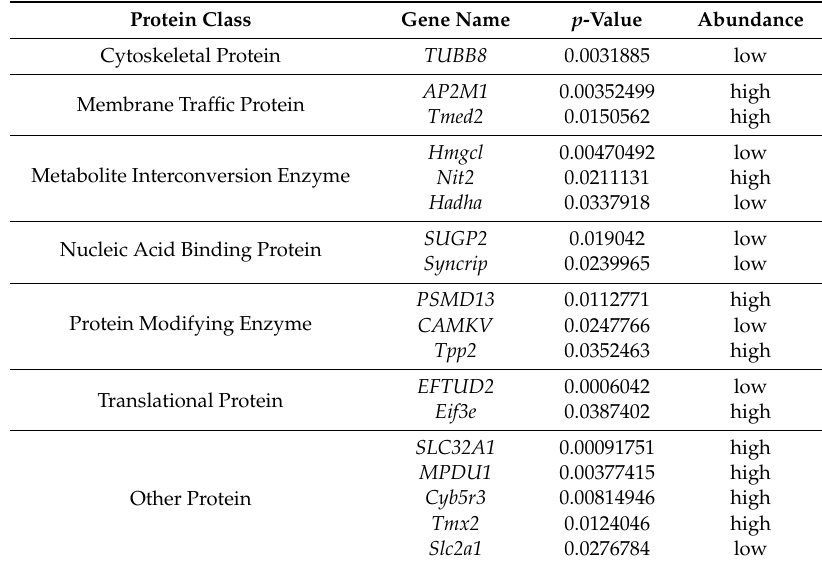
Table 2. List of 18 retinal proteins which were restored in H 2 S treated group. Proteins were classified into di ff erent categories by PANTHER classification system.